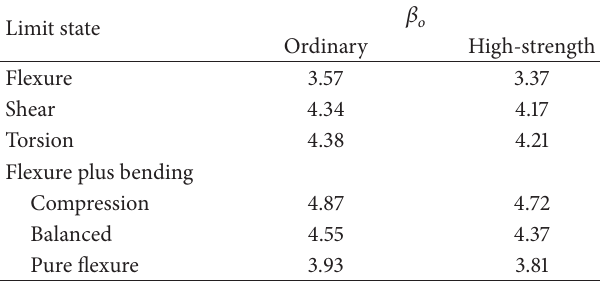
Table 5: 𝛽 𝑜 values for RCDF-04.